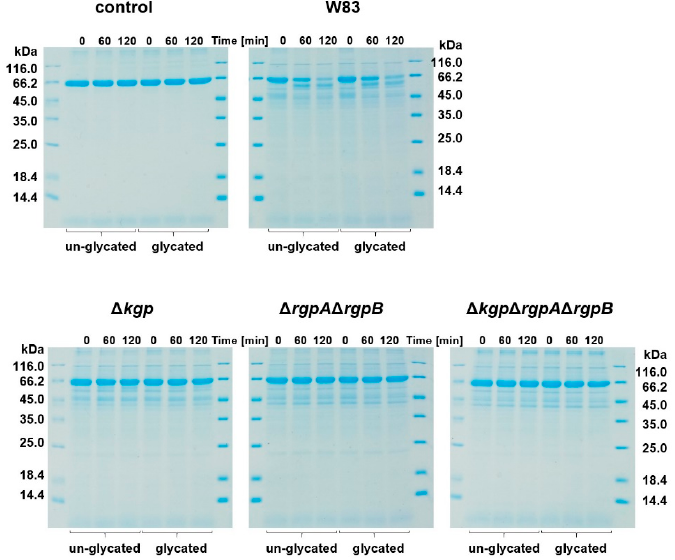
Figure 8. Susceptibility of albumin to proteolytic activity of P. gingivalis . W83, wild-type P. gingivalis strain; Δ kgp , Δ rgpA Δ rgpB , Δ kgp Δ rgpA Δ rgpB , gingipain mutant strains lacking functional genes encoding lysine-specific Kgp and/or arginine-specific RgpA and RgpB, constructed in W83 strain.